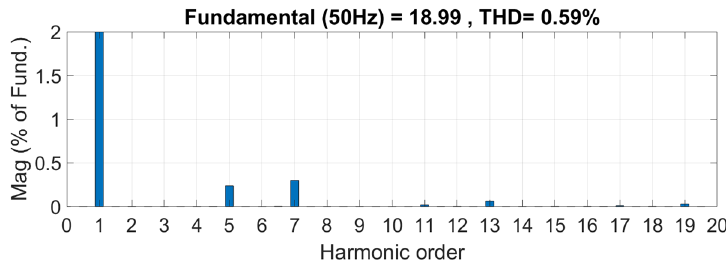
Figure 10. FFT analyzer for source current with APF using MPM extraction at load change.